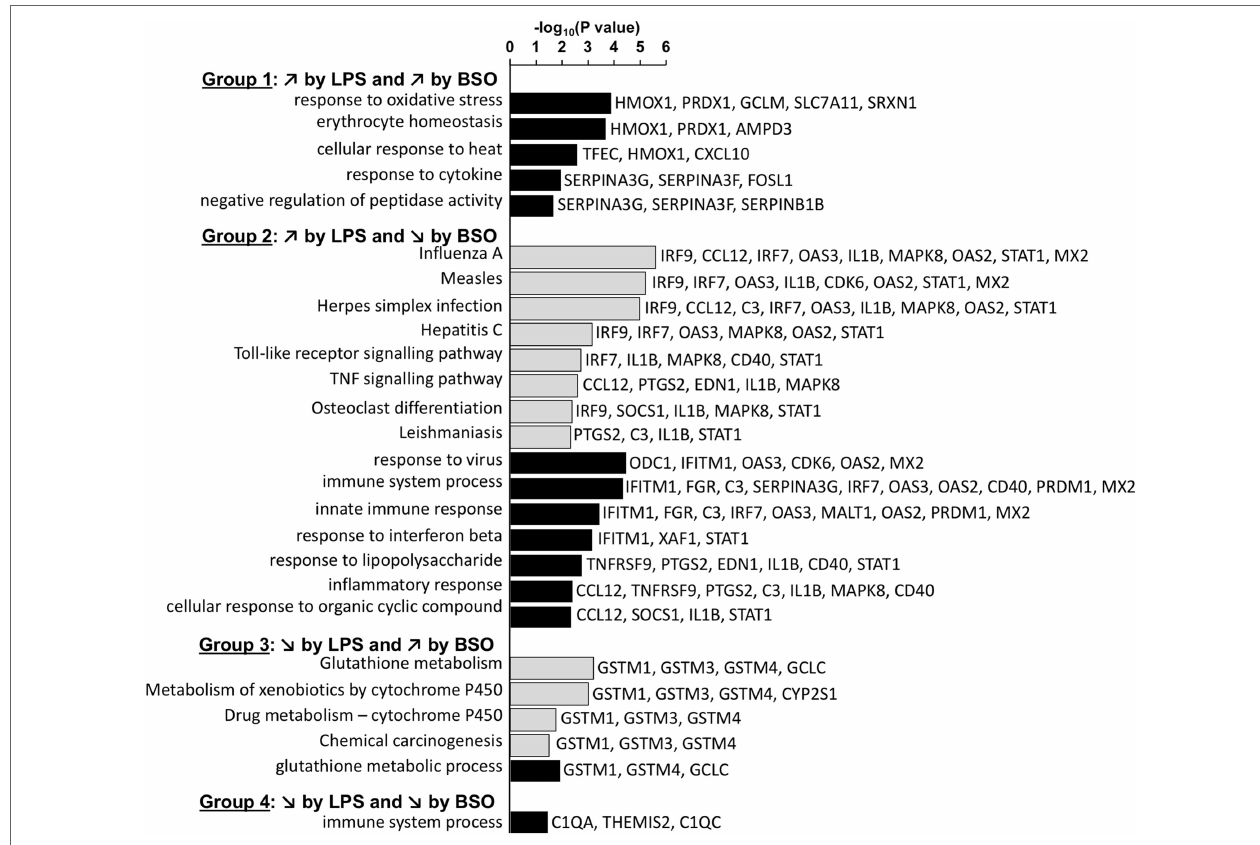
FigUre 4 | Enriched functional categories in the four groups of genes differentially regulated by LPS and BSO. The lists of genes in the four groups at 2 and 6 h were combined and the overrepresented GO biological process (GO:BP) categories (white bars) and KEGG pathways (gray bars) were obtained by DAVID analysis. All categories identified by DAVID for Groups 1–4 are reported. For Group 2, DAVID returned 51 categories and only the top 15 (ordered by EASE score, a modified Fisher’s exact test) are reported. BSO, buthionine sulfoximine; GO:BP, gene ontology biological process; LPS,